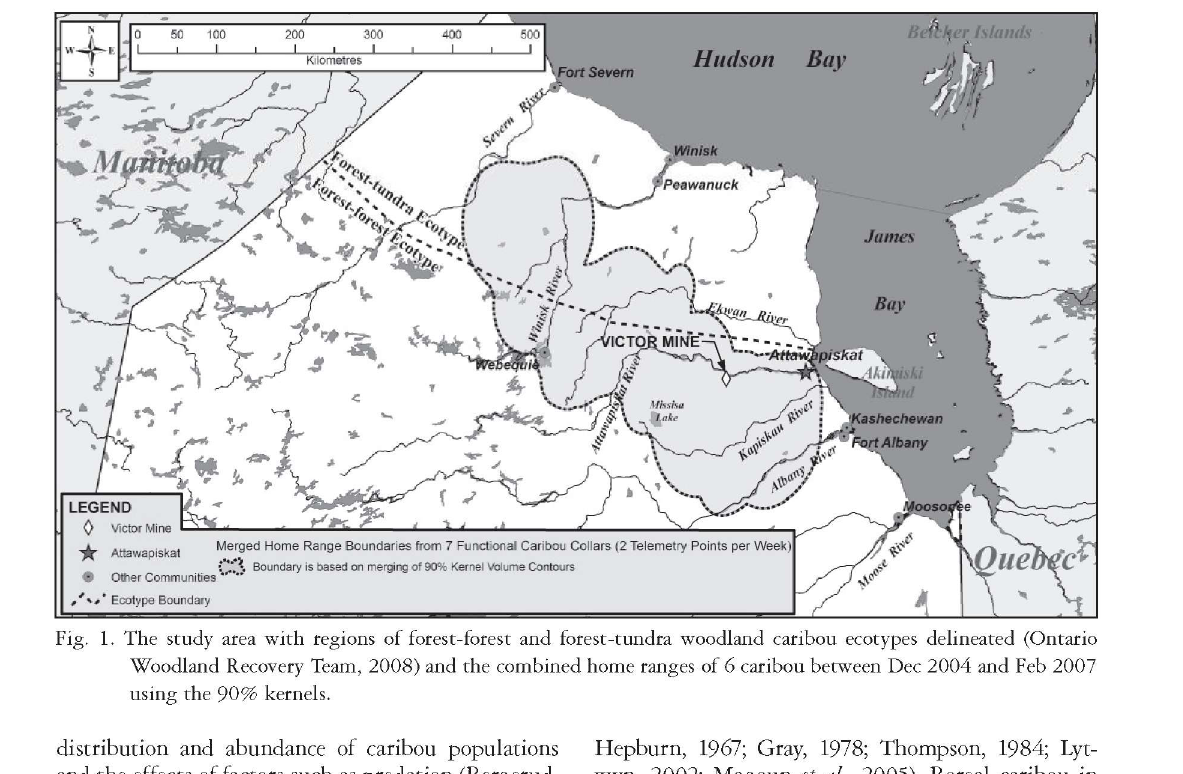
Fig. 1. The study area with regions of forest-forest and forest-tundra woodland caribou ecotypes delineated (Ontario Woodland Recovery Team, 2008) and the combined home ranges of 6 caribou between Dec 2004 and Feb 2007 using the 90%